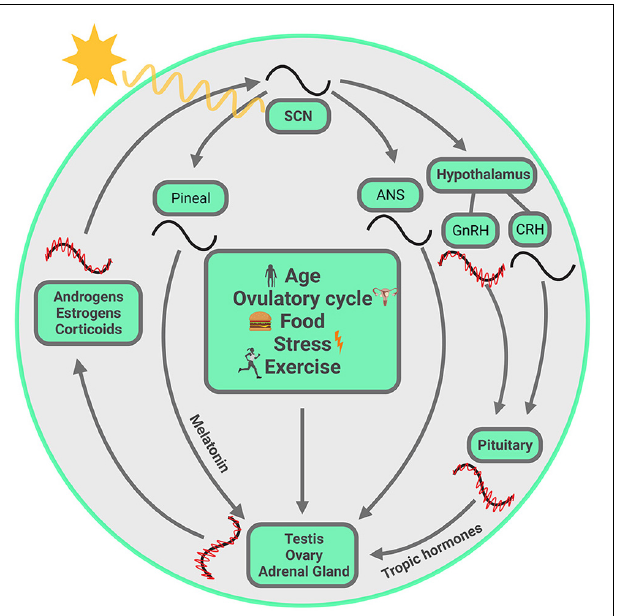
FIGURE 1 | Visual summary of processes discussed in this review. The SCN, entrained by the ambient light, drives the daily variation of steroids from gonads and adrenal glands, chiefly but not exclusively through the hypothalamus-pituitary-axis. Within each gland, circadian clocks modulate steroid biosynthesis at several steps in the pathway, and these are unique to each gland. The steroids circulate in the systemic blood supply and reach the SCN where they act on their cognate receptors, thereby fine-tuning the SCN output. At multiple points, ultradian oscillation is necessary for circadian oscillation. These oscillations at different temporal scales are synchronized from one level to the next. Other entraining signals, such as age, ovulatory cycle, food, exercise and stress, may not act on SCN directly, but can modulate hormone synthesis from gonads and adrenals, with the consequence that circulating steroids reach the SCN and modulate its output. Symbols: red waves = ultradian oscillation, black waves = circadian oscillation. The ultradian rhythm of CRH is not included as it is not required for generating ACTH and CORT pulsatility (Walker et al., 2012). The ultradian oscillations are not drawn for SCN, melatonin and ANS as their ultradian rhythms are not covered in the current